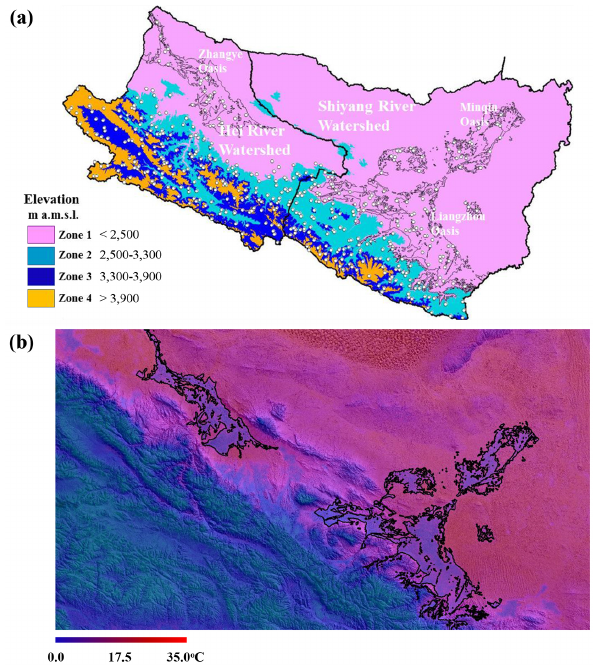
Figure 2. Division of study area according to four elevation zones ( a ; legend) and mean July air temperature distribution (b) used in the computational fluid-flow dynamics modelling of sur- face wind velocity (ms − 1 ) and wind direction ( ◦ from true north, N). Open circles in (a) give the randomly selected point loca- tions where enhanced vegetation index (non-dimensional), evapora- tion (kgm − 2 month − 1 ) , and precipitation (kgm − 2 month − 1 ) were